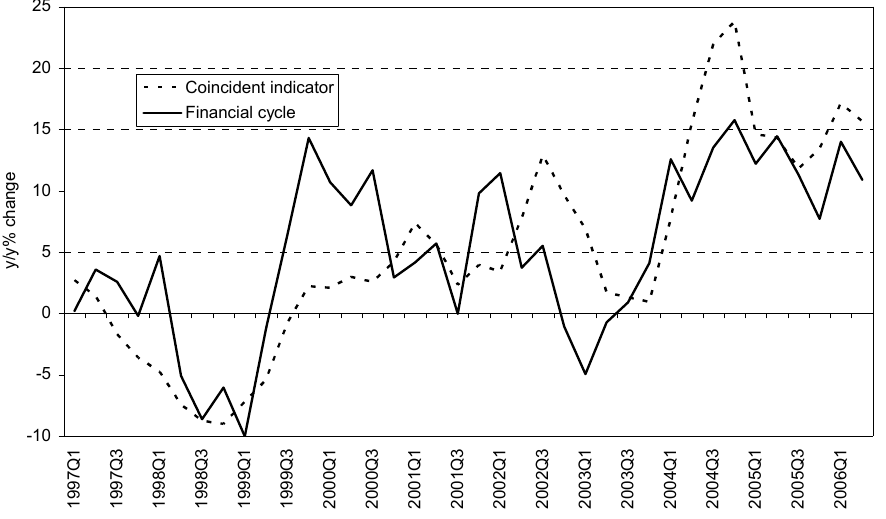
FIGURE 4: Coincident indicator vs. the financial